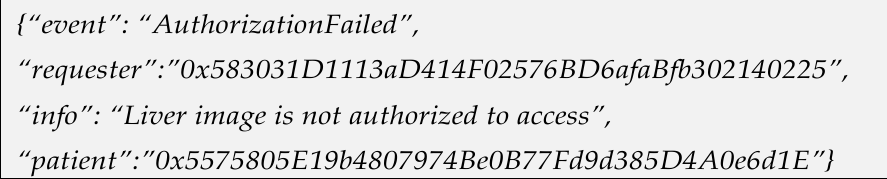
Figure 9. Case 4: event log where the IR 2 address is not authorized to access a patient medical image.